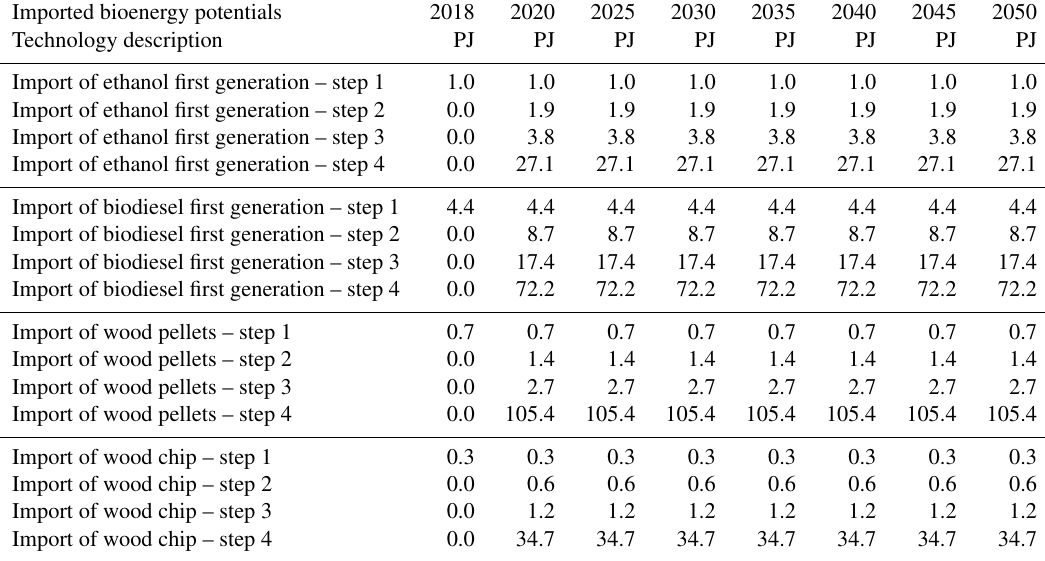
Table A4. Import bioenergy